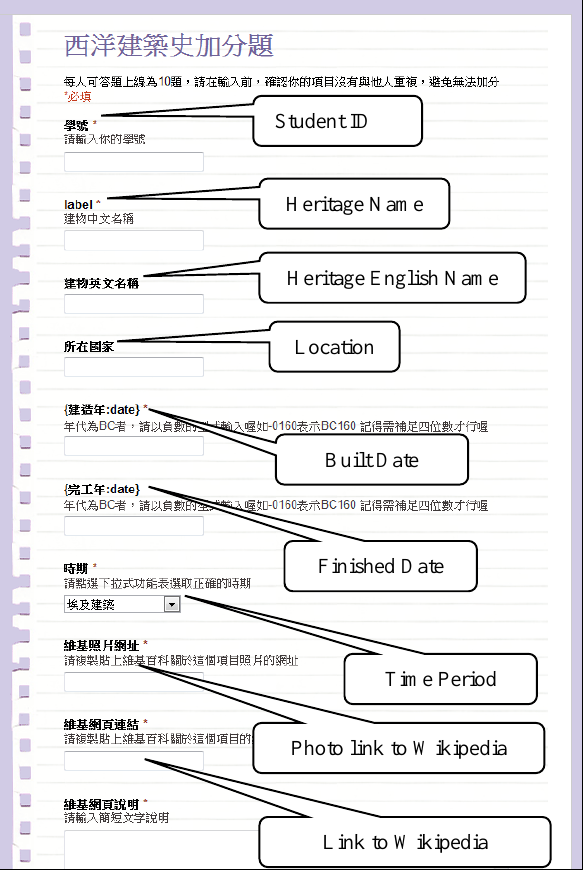
Figure 2. Google spreadsheets online form